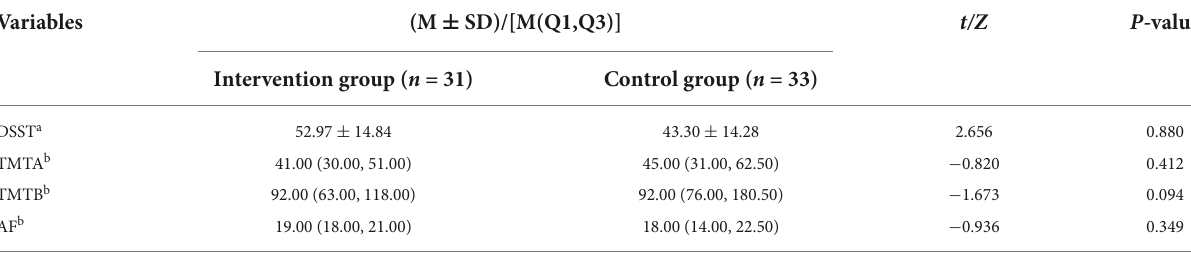
TABLE 2 Comparison of baseline cognitive function between the intervention group and the control group. Variables